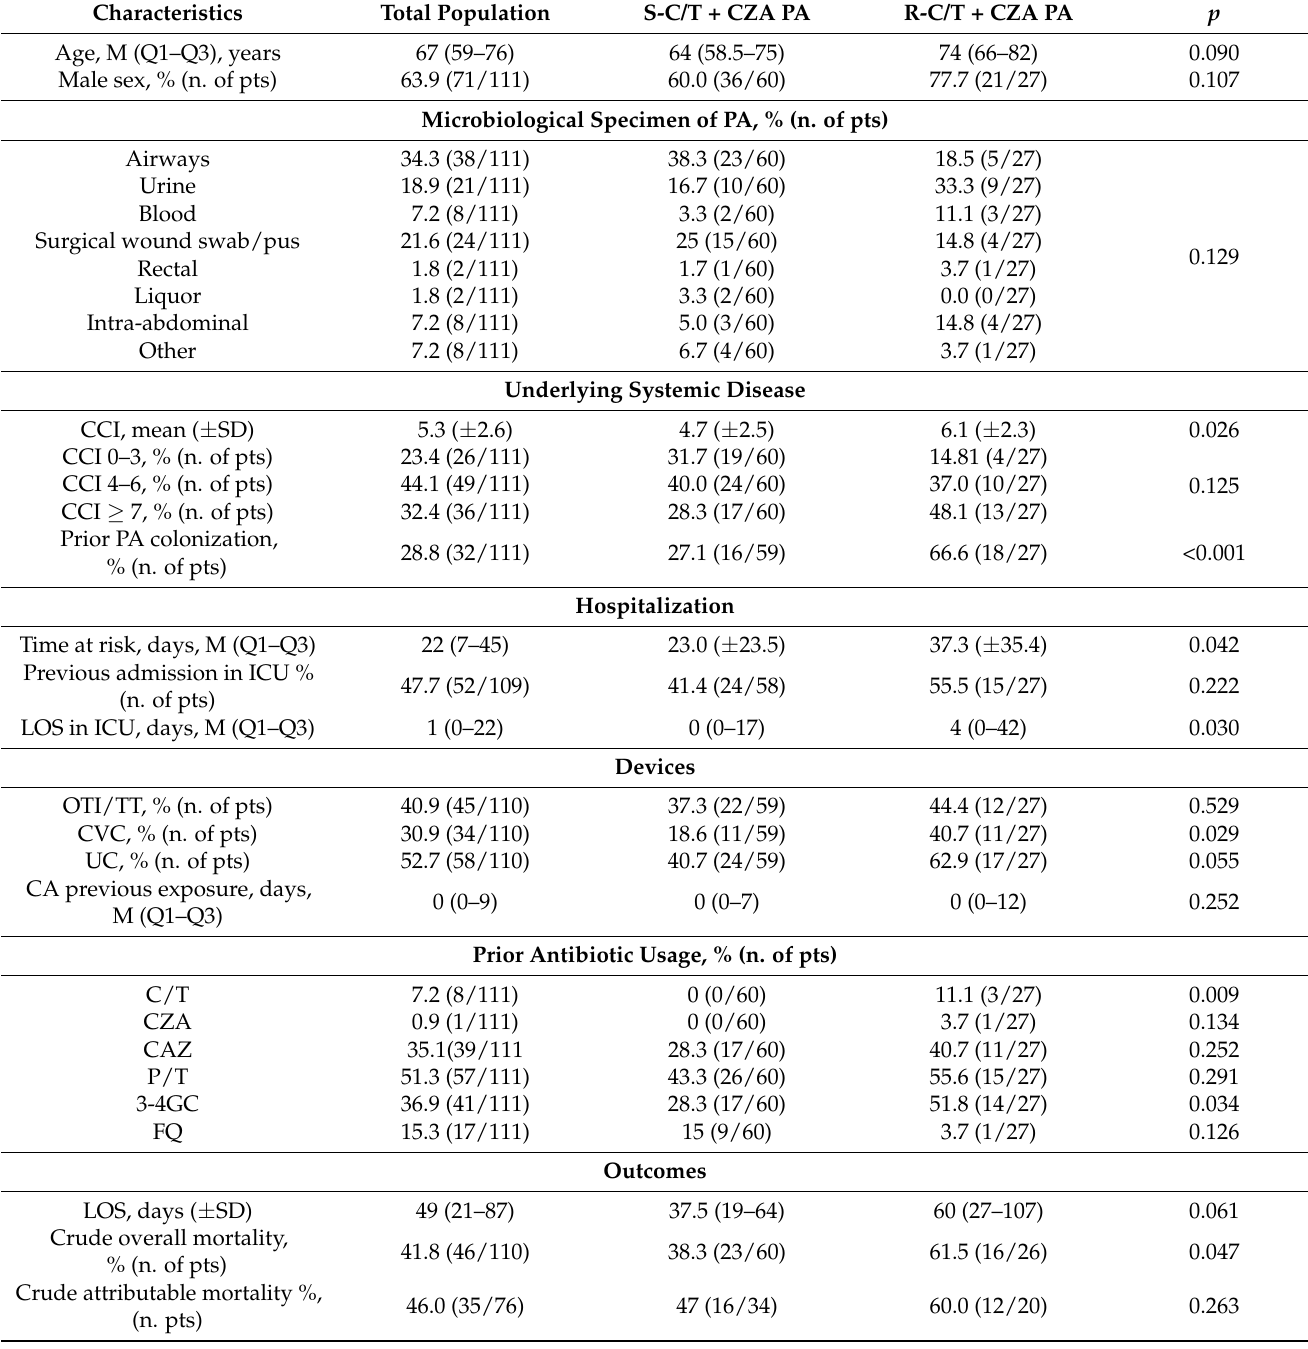
Table 1. Comparison of demographic and clinical characteristics between patients colonized/infected with S-C/T + CZA and R-C/T + CZA